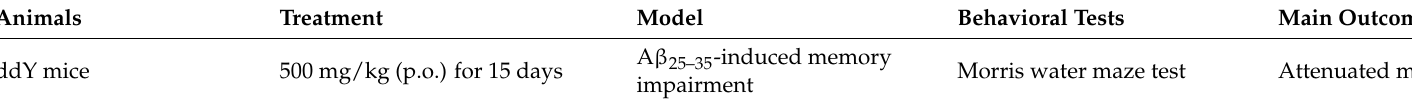
Table 6. Summary of in vivo studies on the neuroprotective effects of